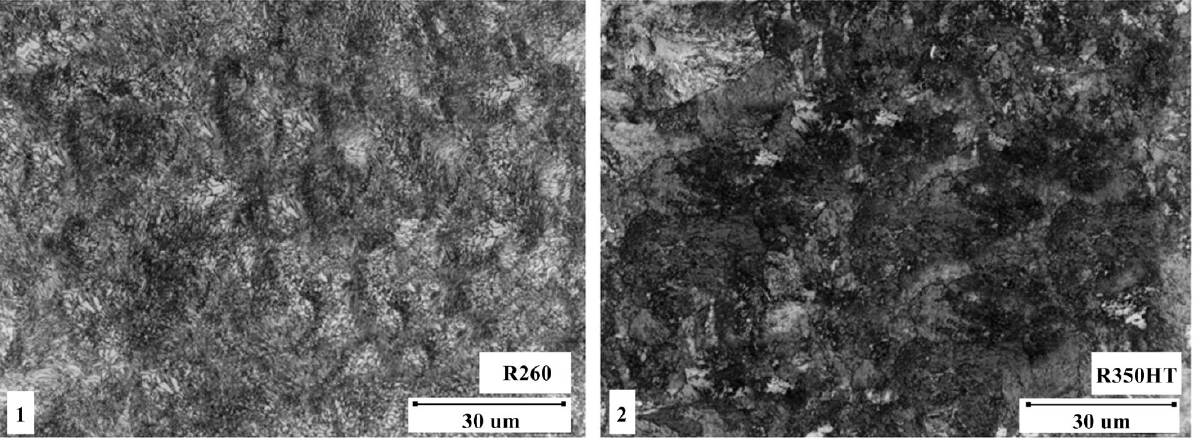
Figure 5. Microphotographs taken with an optical microscope: 1 —a section from the R260 rail, 2 —a section from the R350HT rail, image of pearlitic grains in the microstructure. Source: own.